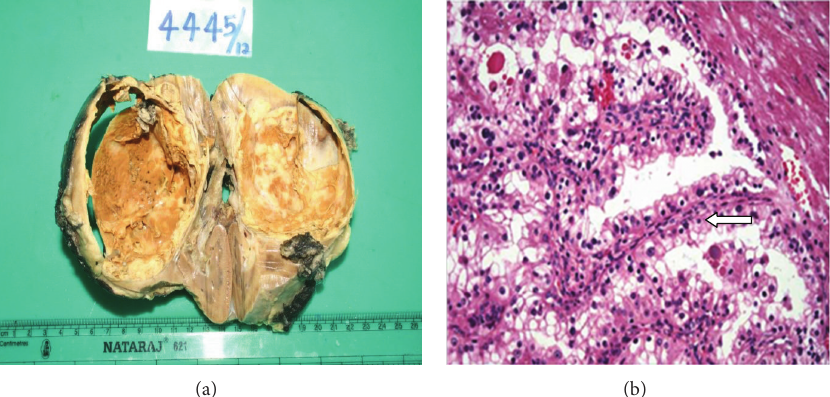
Figure 3: (a) Cut surface showing well encapsulated predominantly unilocular cystic lesion with grey brown solid areas with focal areas of haemorrhage measuring 7.5 × 9 × 7cm in size. (b) Microscopically, cells are arranged in papillary pattern (arrow) with some areas showing alveolar and nesting pattern. Cells showed abundant clear to eosinophilic cytoplasm with prominent nucleoli.